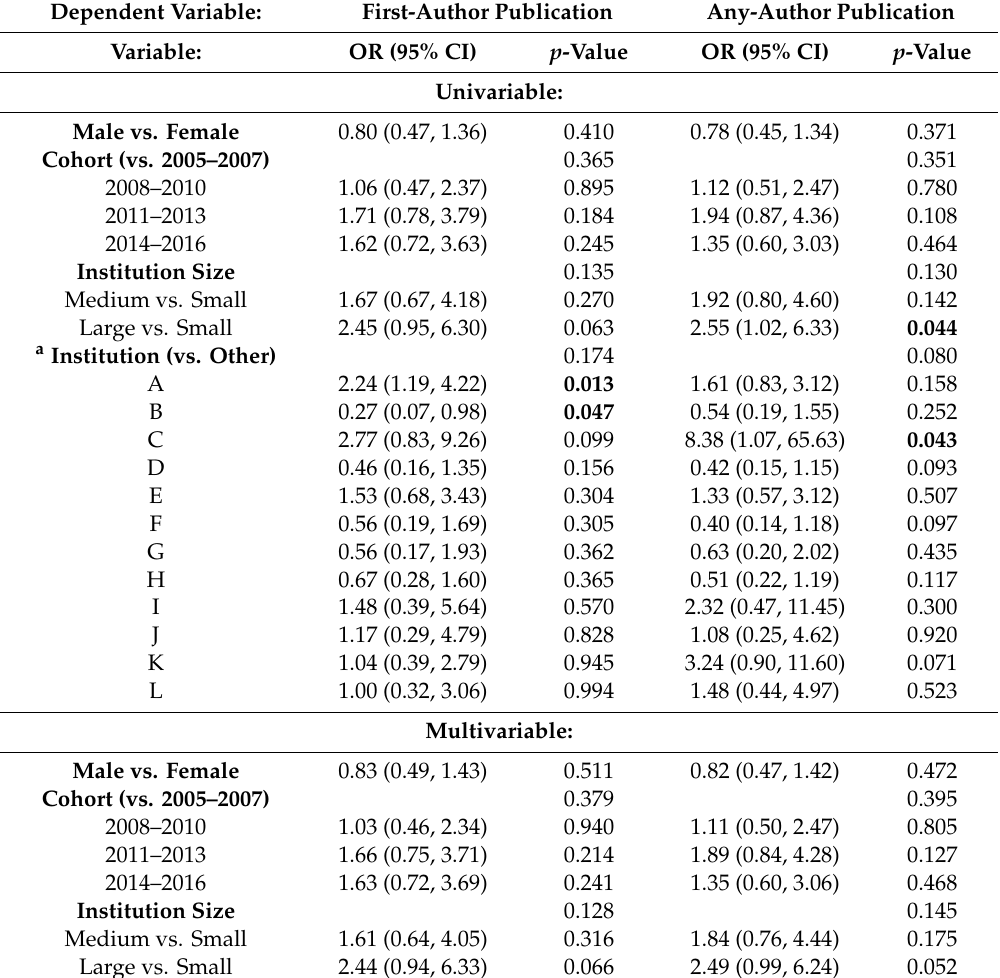
Table 3. Univariable and multivariable logistic regression models predictive of first-author and any-author publications ( n =